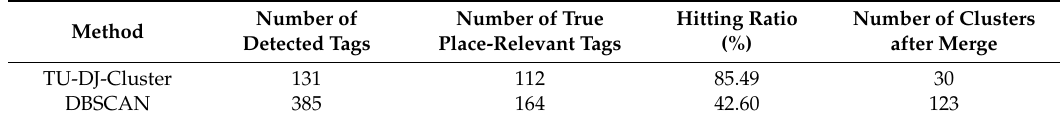
Table 2. Place-relevant tag detection results of two methods.